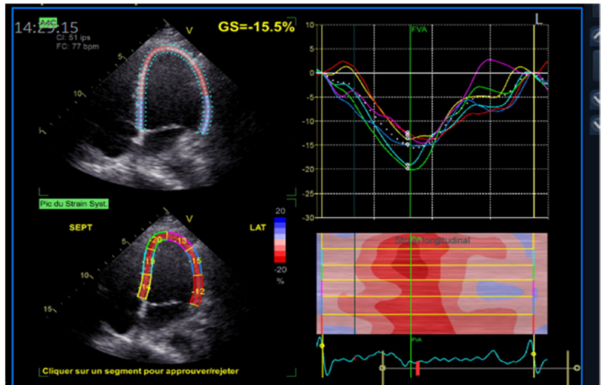
Figure 6. Longitudinal strain measurement in apical 4CH view.